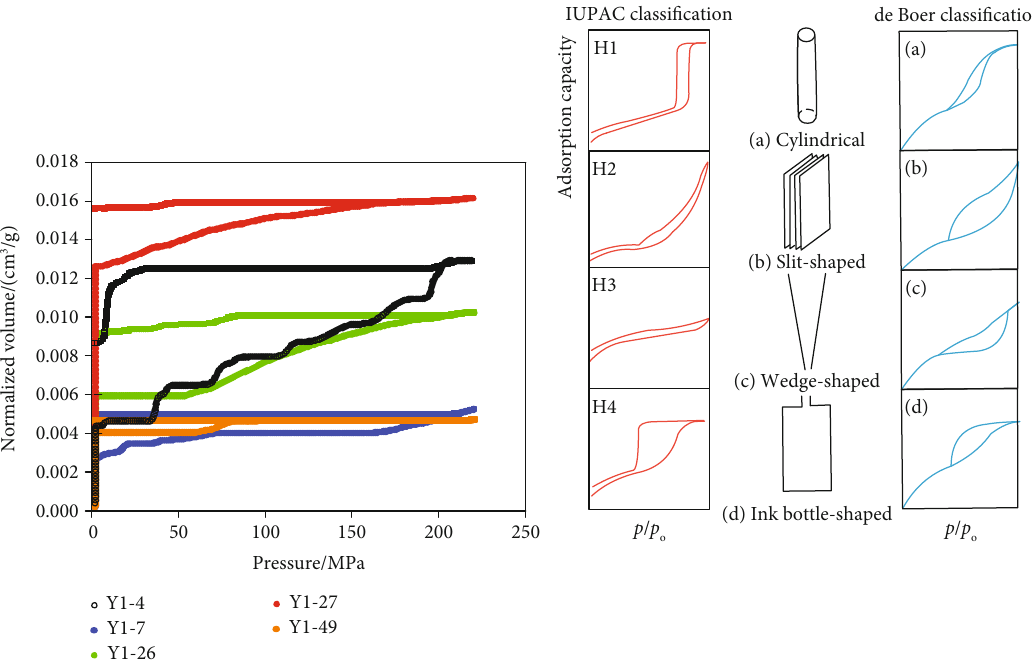
Figure 6: Mercury advance and retreat curve and corresponding pore types of samples from well Y1 [11]